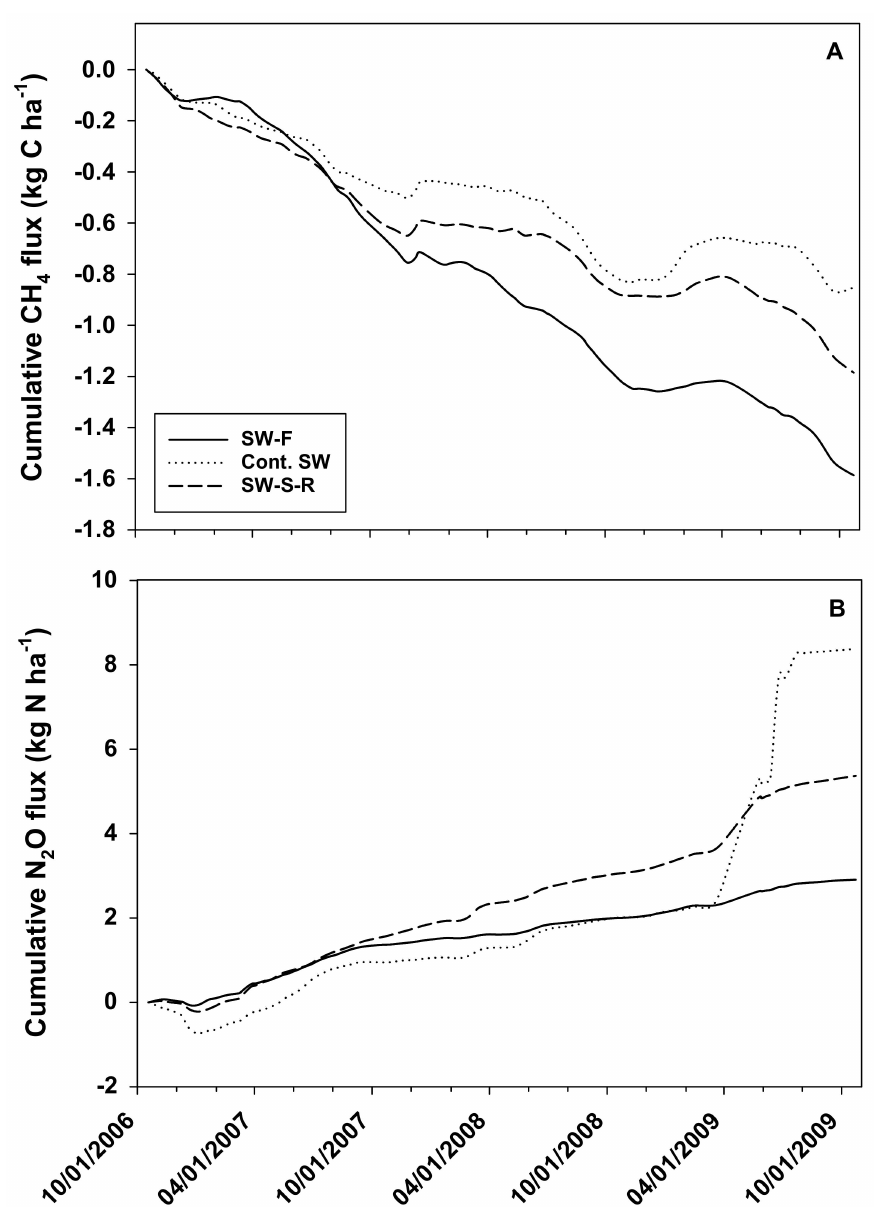
Figure 5. Cumulative flux of CH 4 ( A ) and N 2 O ( B ) for spring wheat–fallow (SW-F), continuous spring wheat (Cont. SW) and spring wheat–safflower–rye (SW-S-R) cropping systems from 18 October 2006 through 23 October 2009.